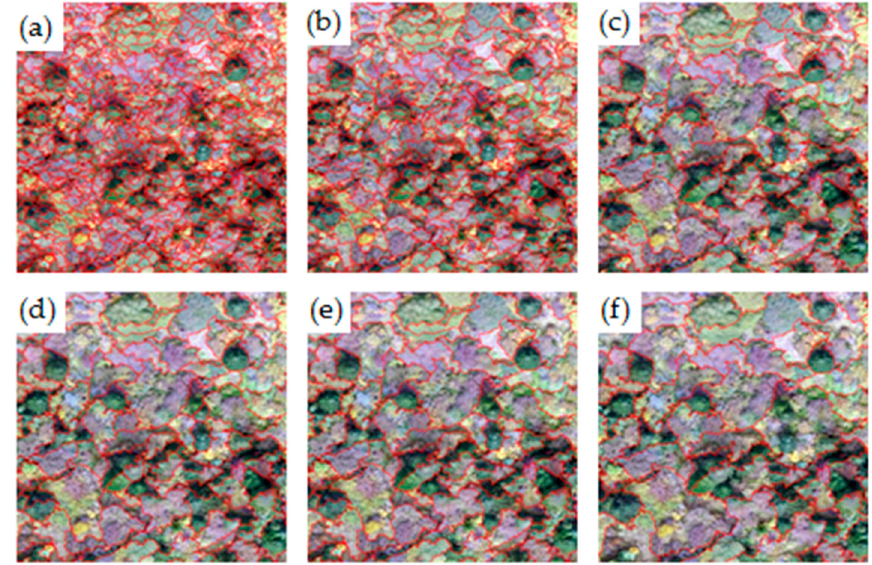
Figure 10. Individual tree canopy segmentation with scales of 29, 45, 102, 112, 127, and 167.